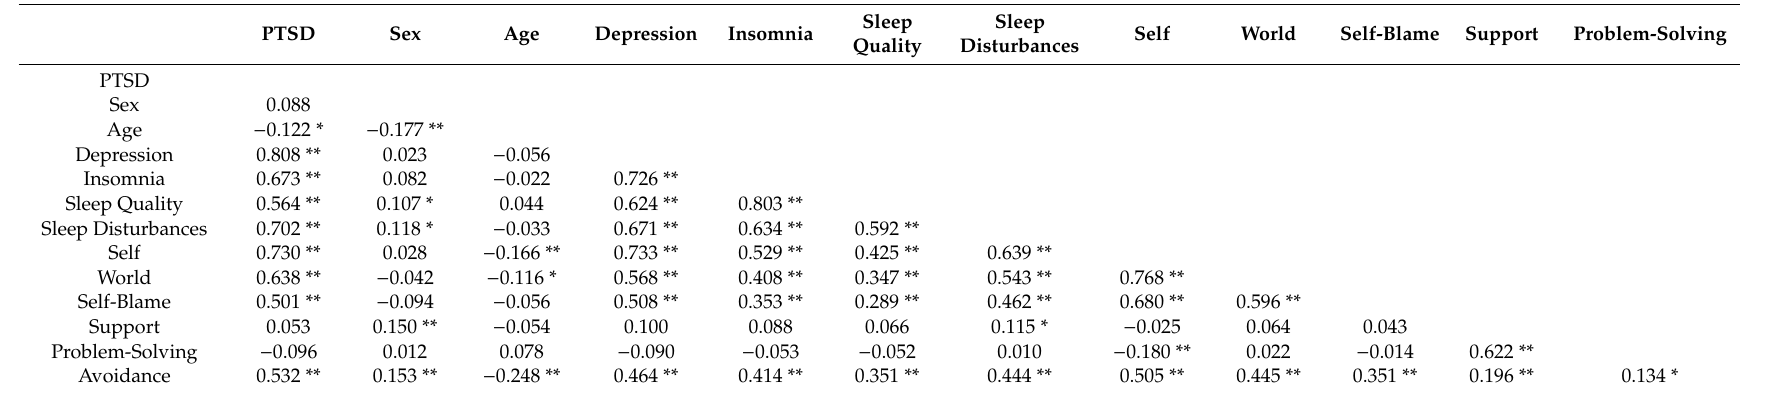
Table 4. Correlation coe ffi cients between variables ( n =